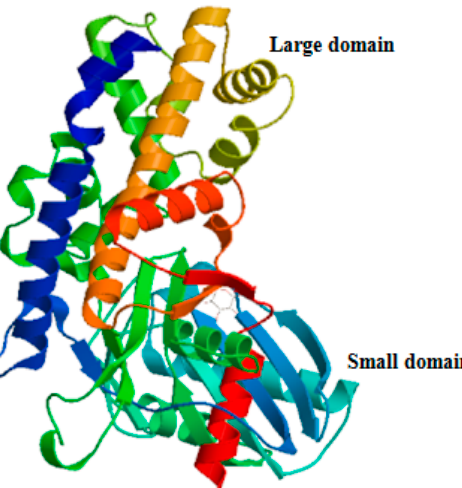
Figure 4. Three-dimensional (3D) structures of M. nipponense hexokinase (HK) predicted using human hexokinases II as template models. Different secondary structure was marked in different colors.